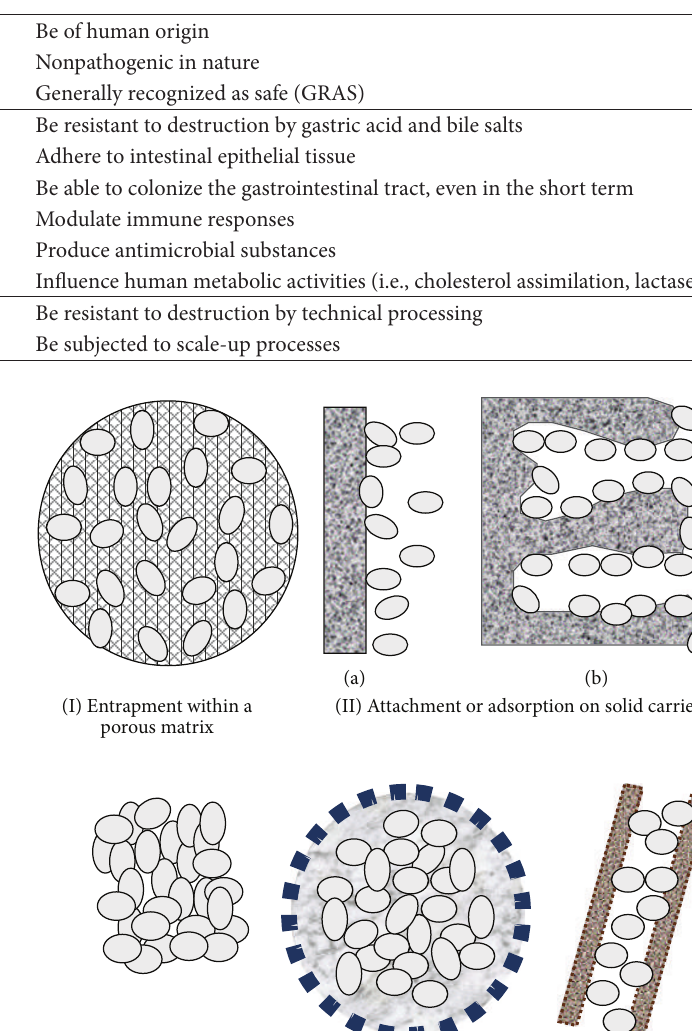
Table 3: Criteria used to define a probiotic microorganism.